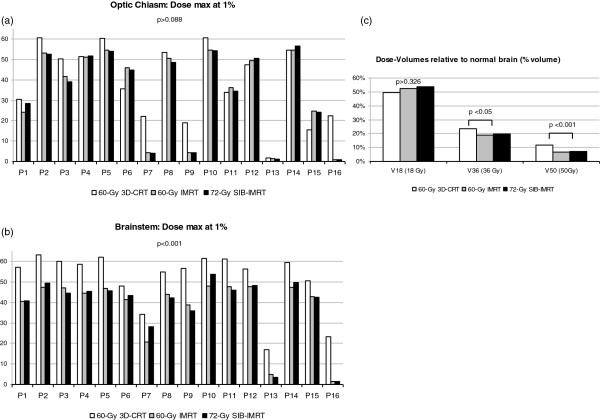
Comparison of the doses received by OAR between 60-Gy 3D-CRT, 60-Gy IMRT and 72-Gy SIB-IMRT for all patients (P1 to P16). Doses relative to 60-Gy 3D-CRT are drawn in white, grey for 60-Gy IMRT and black for 72-Gy SIB-IMRT. No significant difference is found when considering the maximum dose received by 1% of the optic chiasm (41.63 vs 45.47 and 42.08 Gy, p > 0.088) (Figure 4a). For the brainstem, the maximum dose received by 1% of the organ is significantly lower (57.01 vs 44.30 and 44.00 Gy, p < 0.001) in 60-Gy IMRT and 72-Gy SIB-IMRT (Figure 4b). Histograms of dose-volumes relative to normal brain comparing 60-Gy 3D-CRT (white), 60-Gy IMRT (grey) and 72-Gy SIB-IMRT (balck) are shown on Figure 4c. No significant difference is found when considering the V18 (p > 0.326). 60-Gy IMRT and 72-Gy SIB-IMRT were significantly smaller for V36 and V50 (19 and 20 vs. 23%, p = 0.049,7 and 7 vs. 12%, p < 0.001). No significant differences for V36 and V50 were found between 72-Gy SIB-IMRT and 60-Gy IMRT (p = 0.605).